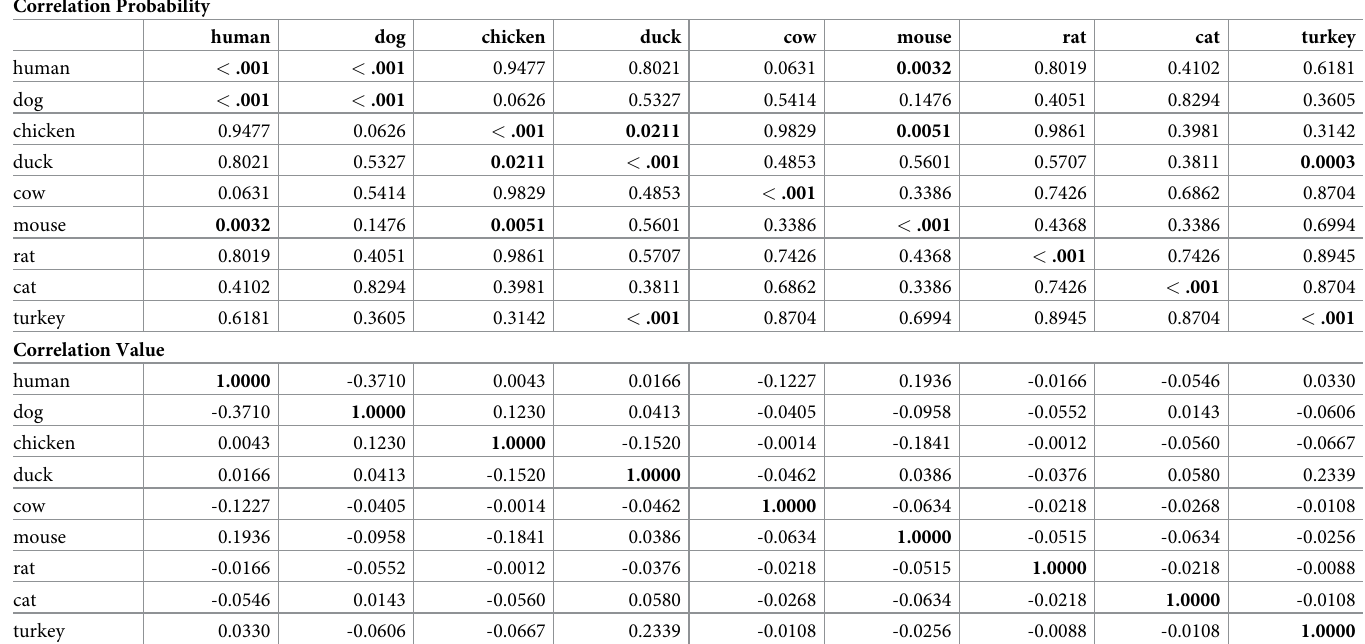
Table 1. Multivariate correlations among blood sources (N = 232).